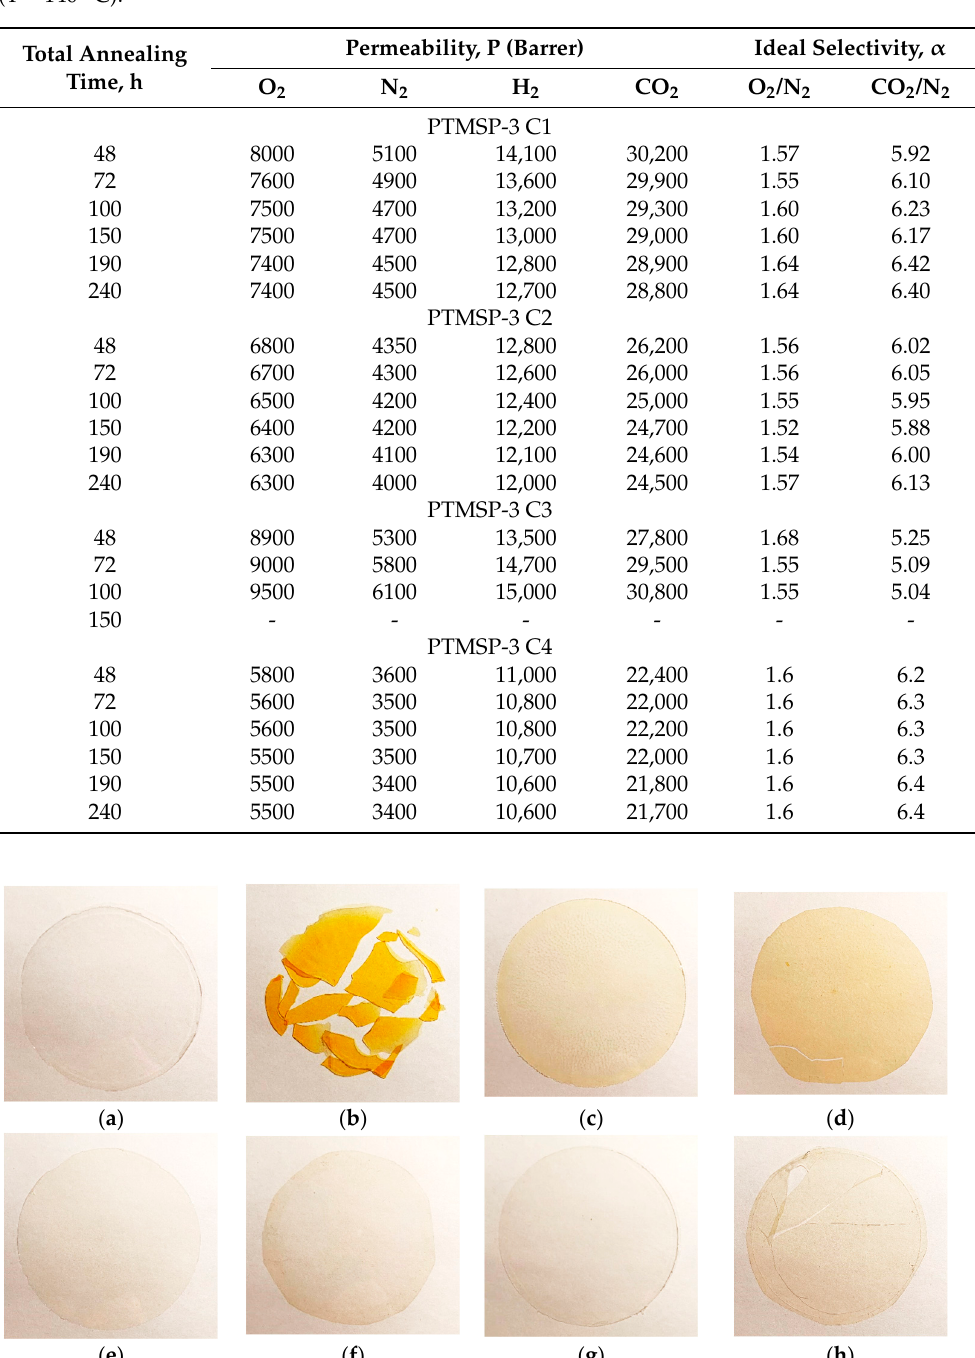
Table 5. The change in permeability coefficients of PTMSP-3 films containing stabilizers Irganox